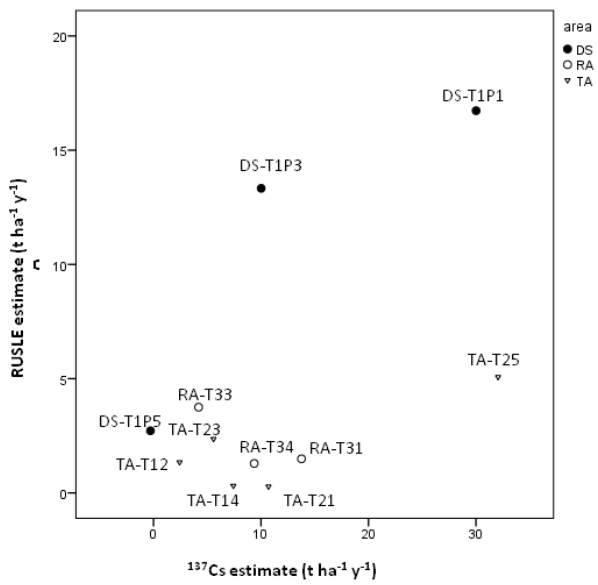
Figure 4. Scatterplot of measured and modeled erosion rates in the study area. DS: defense structures area; TA: track area; RA: release area.